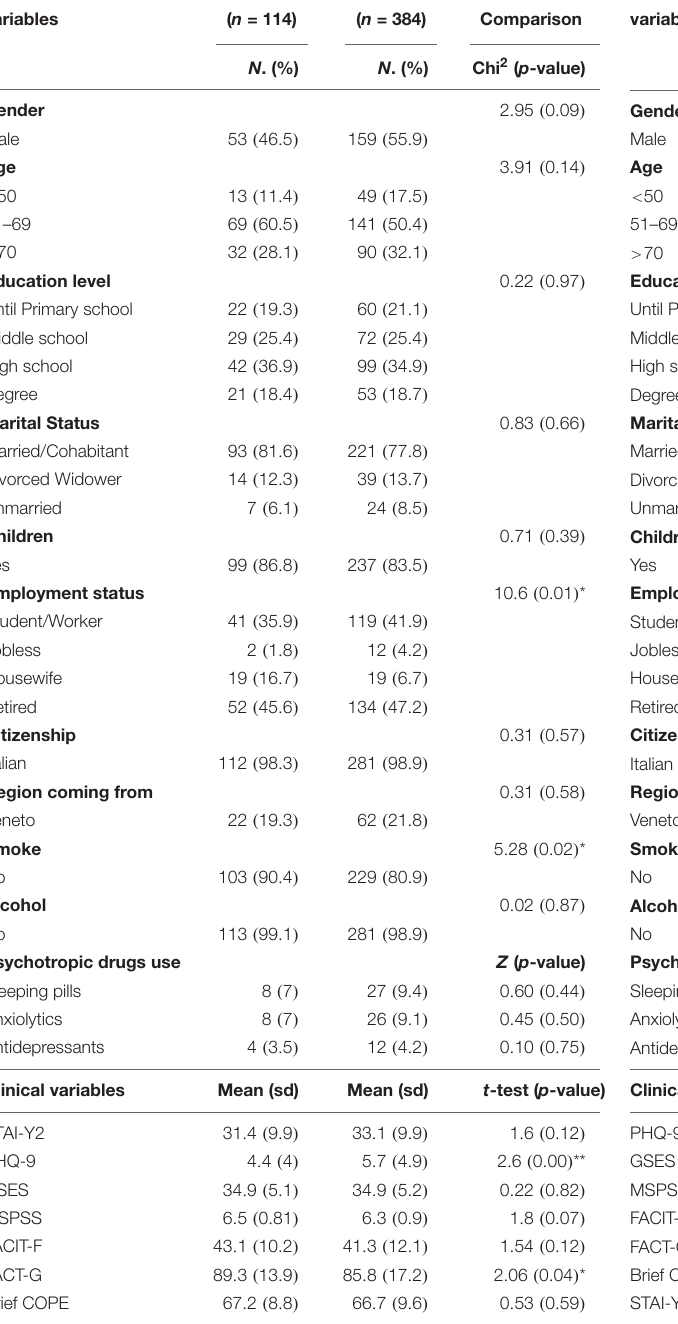
TABLE 5 | Socio-demographic and clinical characteristics of patients distinguished by intervention and “usual care” group at T1 (day before surgery). Socio-demographic